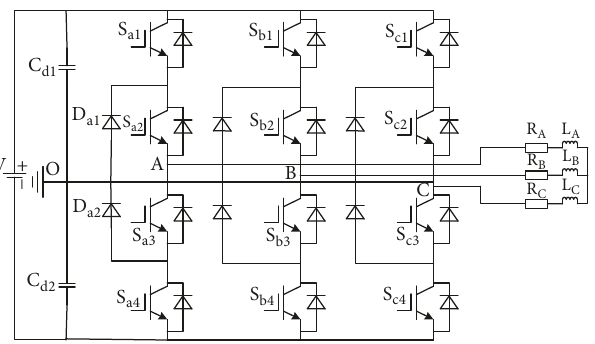
Figure 7: Diode clamped three-level